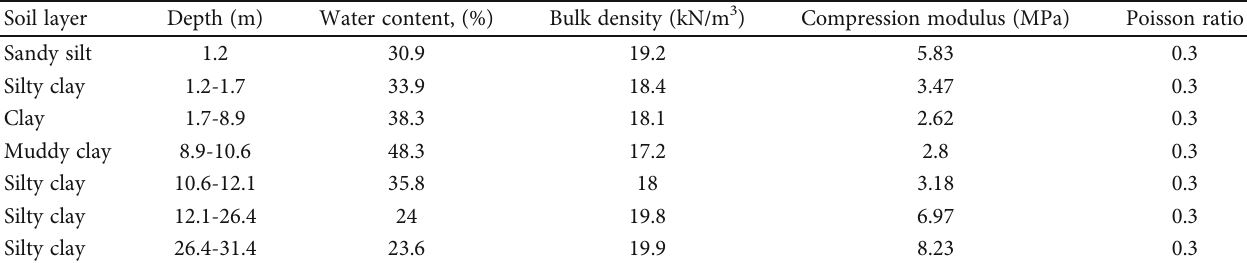
Table 1: Distribution and physical parameters of soil layers.